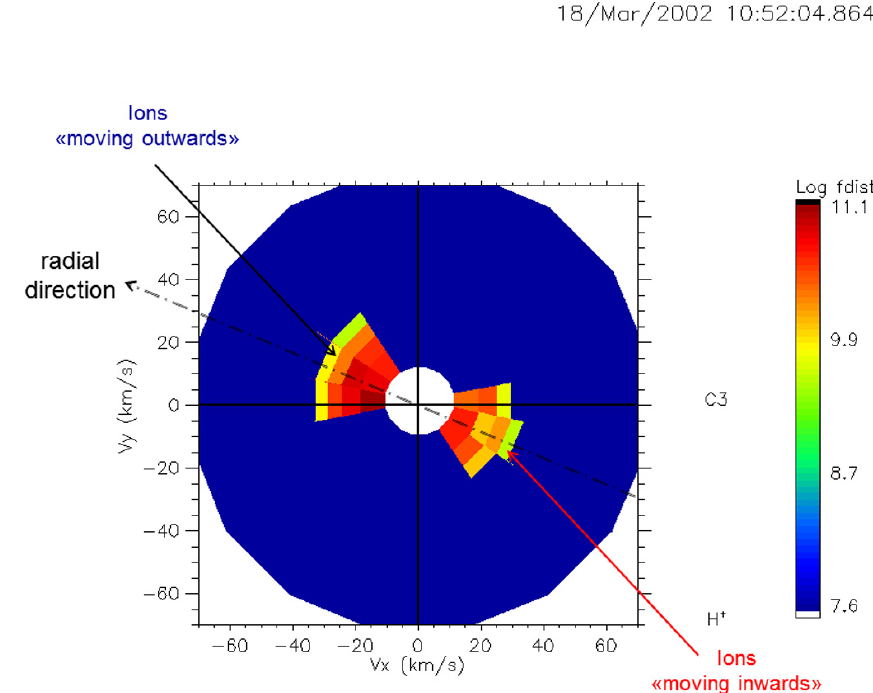
Fig. 6. Partial 2-D distribution function in the outer plasmasphere and close to the magnetic equator, in the x-y plane (GSE): H + ions flowing in the two 67.5 ◦ wide azimuthal sectors that are centred on the radially outward/inward directions respectively. Measurements in azimuthal directions other than these two 67.5 ◦ sectors around the radial direction have been masked for clarity. The white circles at the centre and at the outer edge of the distribution correspond to the RPA lower and upper energy limit respectively. The spacecraft velocity has been removed. Phase space density units (ionss 3 km − 6